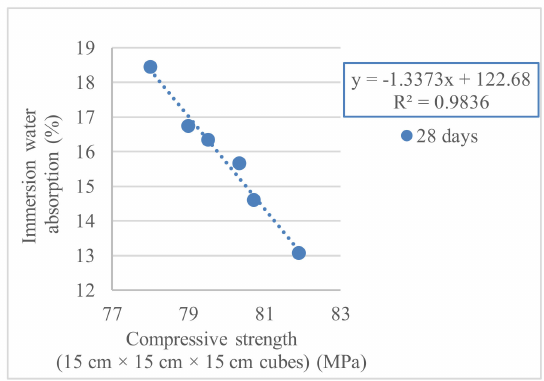
Figure 3. Relationship between immersion water absorption and compressive strength (15 cm × 15 cm × 15 cm cubes) results at 28 days.